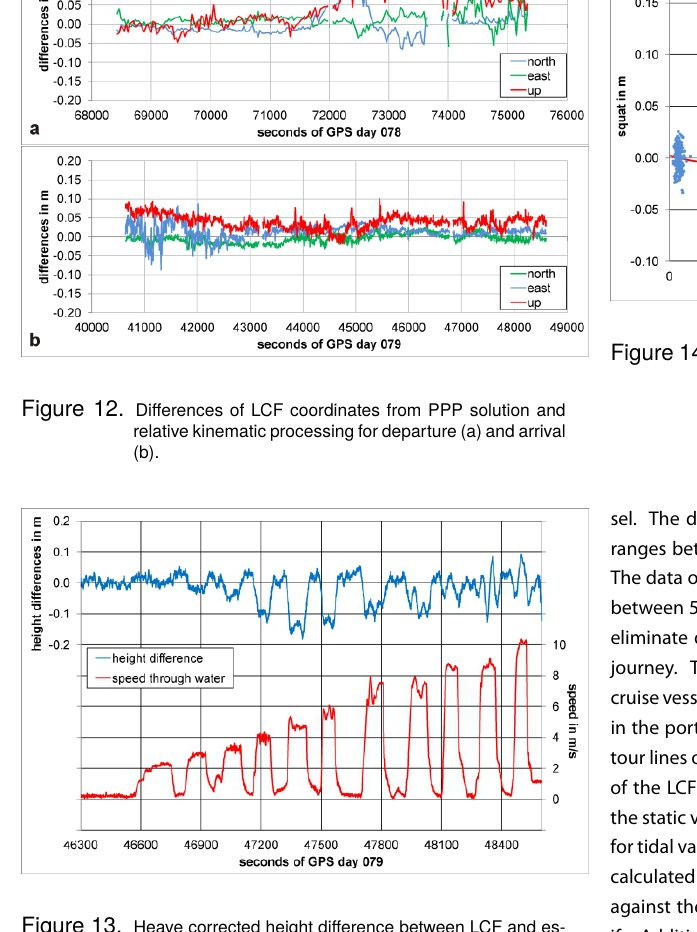
Figure 13. Heave corrected height difference between LCF and es- cort craft’s ARP and speed through water of the escort craft in the port of Funchal.